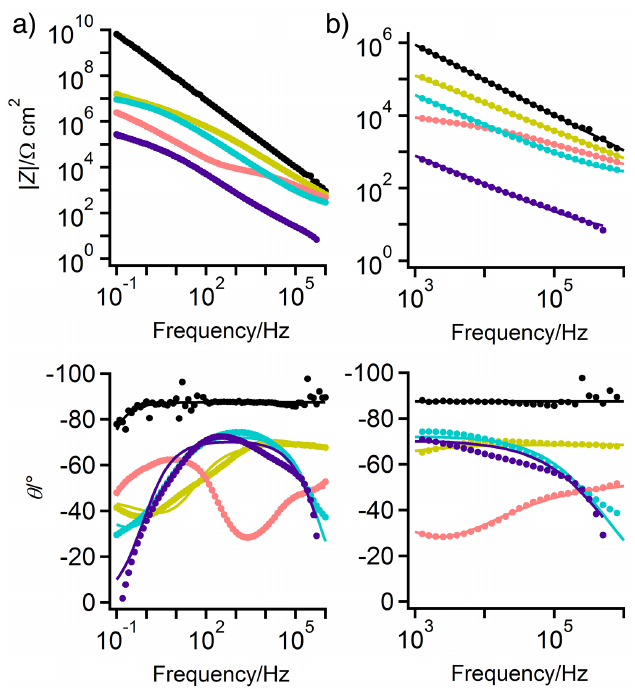
Figure 6. Impedance modulus and phase angle plots for test panels over the full frequency range (column a) and then expanded to show only the higher frequency impedance (column b). Spectra are shown as solid circles for PA (purple), WA (aqua), WPA (pink), W (chartreuse), and B44 (black), with the equivalent circuit fits included as solid lines in their same respective colors.